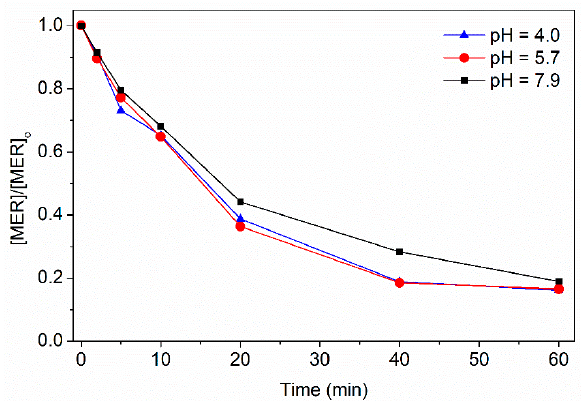
Figure 2. Variation of the MER concentration due to the heterogeneous photocatalytic process with TiO 2 /fiberglass substrates at different pH values ([MER] o = 100 mg/L).